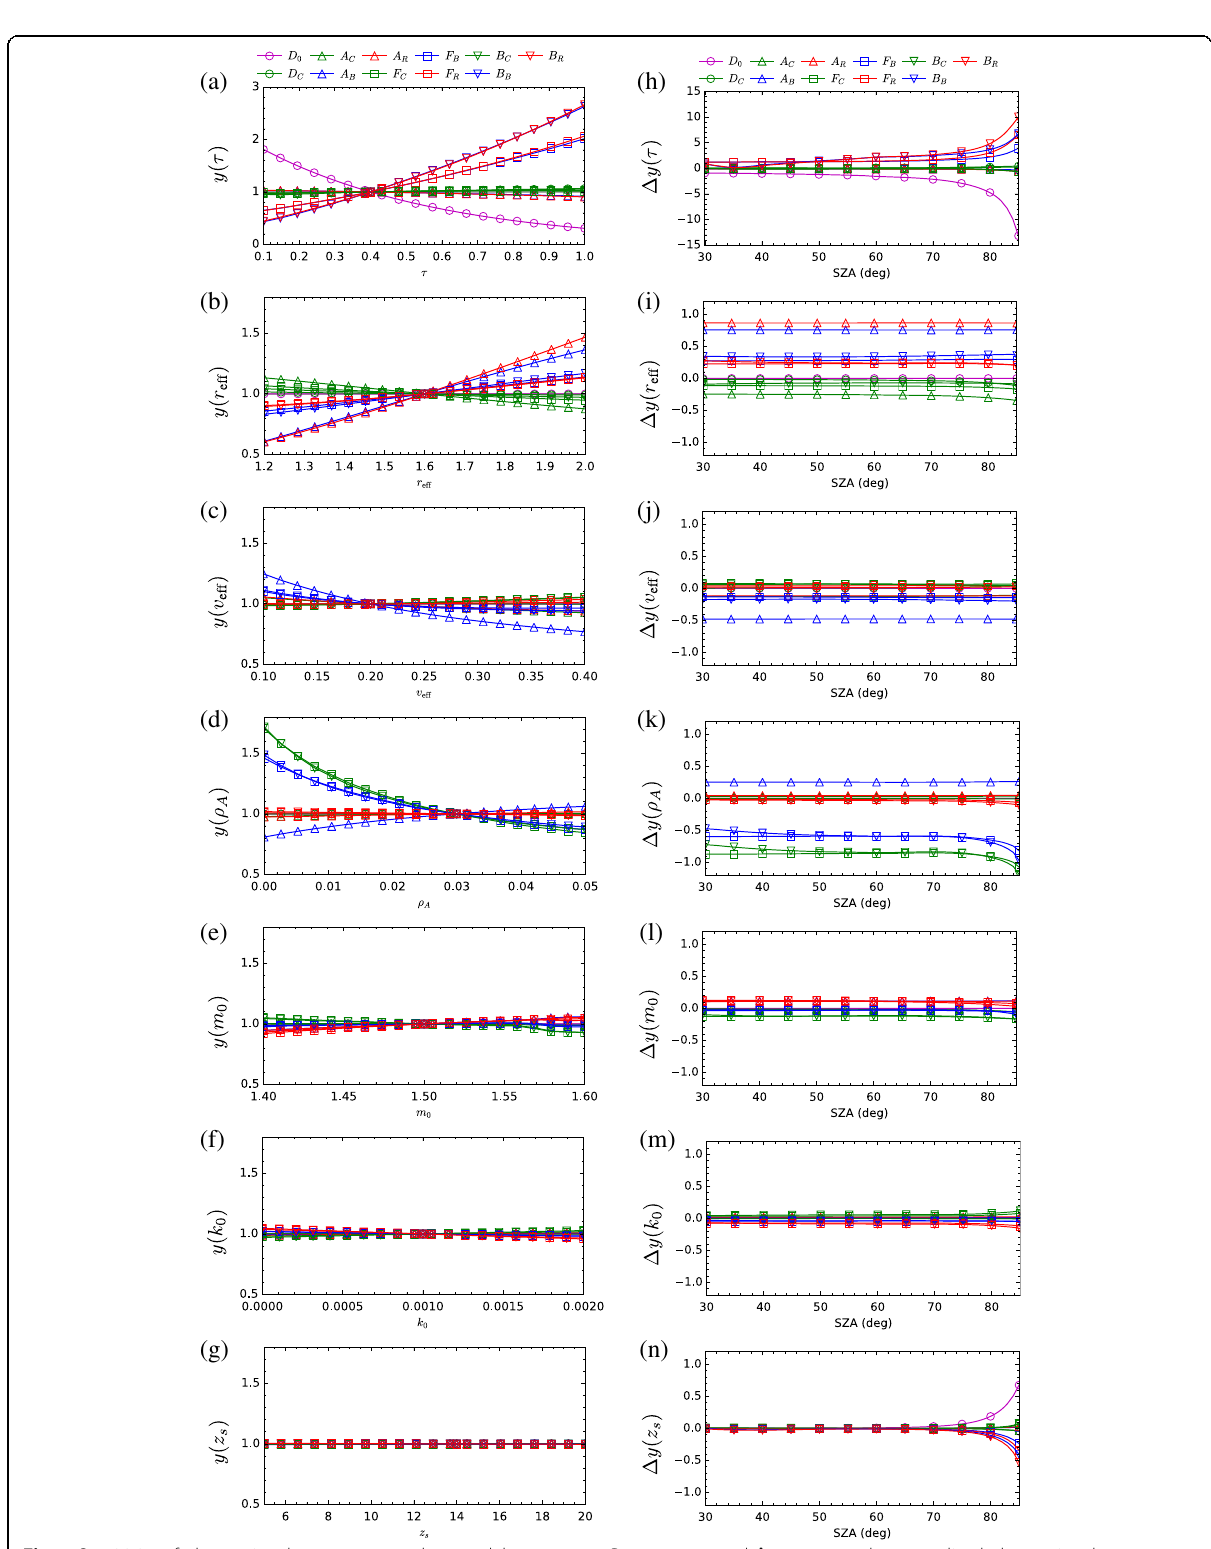
Fig. 5 Sensitivity of observational parameters to dust model parameters. Parameters y and Δ y represent the normalized observational parameter, and the difference between the maximum and minimum values of y when the dust model parameter is changed from its minimum to maximum value, respectively. See Table 5 for the definitions of D 0 , D C , Panels ( a ) - ( g ) show the relation between y ( X i ) and X i for X 1 - X 7 , respectively, and panels ( h ) - ( n ) show that between Δ y ( X i ) and SZA for X 1 - X 7 ,